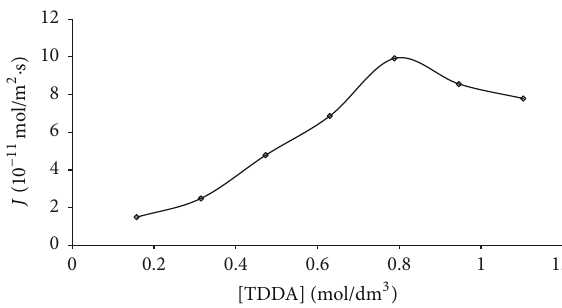
Figure 2: Effect of carrier concentration on transport of Zn (II) in the stripping phase. [HCl] in feed solution = 2.0 mol/dm 3 , [TDDA] in membrane phase = 0.157 mol/dm 3 to 1.103mol/dm 3 , [NaOH] in stripping solution = 2.0 mol/dm 3 , [Zn (II)] = 7.385 × 10 −4 mol/dm 3 , time = 5.0 h.